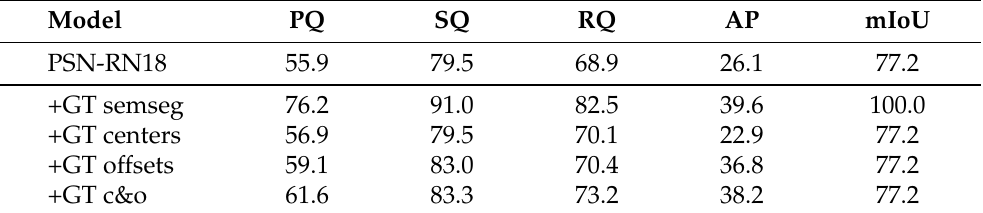
Table 7. Evaluation of models with different oracle components. Labels +GT X denote models which use ground truth information for the prediction X. Note that c&o denotes centers and offsets.